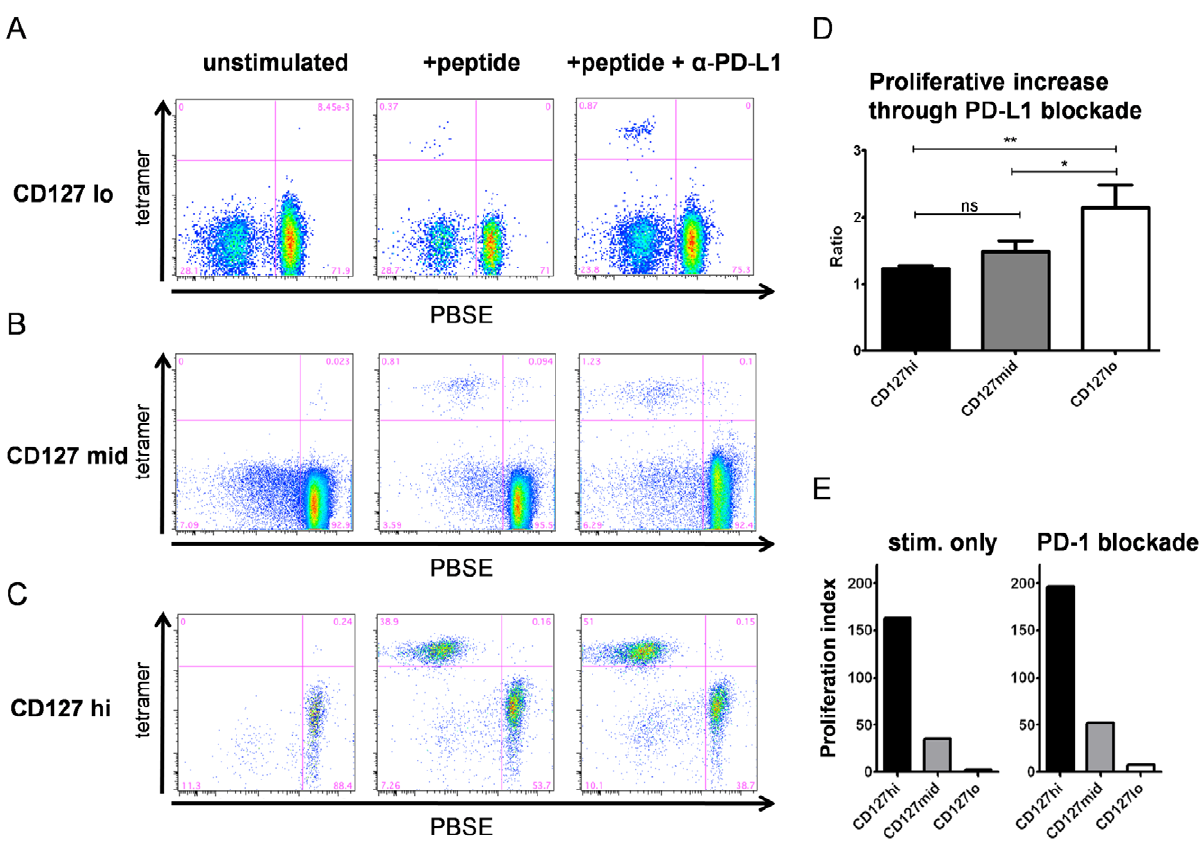
Figure 4. Proliferative capacity and exhaustion inversely correlate with CD127 expression. Proliferation of HCV-specific CD8 + T cells upon peptide stimulation in the presence or absence of PD-L1 blockade was measured by reduction in PBSE fluorescence in short term cultures of 15 patients. Representative stainings are shown for (A) CD127lo (pt.4-NS5-2594), (B) CD127mid (pt. 13-NS3-1073) and (C) CD127hi (pt. 32-NS5-2594) HCV- specific CD8 + T cells. (D) Comparison of the increase in proliferation depending on PD-L1 blockade. Depicted are the mean values and SEM for the ratio (frequency of HCV-specific CD8 + T cells after peptide stimulation and PD-L1 blockade/frequency of HCV-specific CD8 + T cells after peptide stimulation). This ratio reflects the effect of PD-L1 blockade in addition to peptide stimulation. PD-L1 blockade in the cohort analyzed was significantly more effective for peptide-stimulated CD127lo cells (mean 2.2) than for CD127mid (mean 1.5) and CD127hi cells (mean 1.2) (p , 0.01). (E) Proliferation index of peptide-stimulated HCV-specific CD8 + T cells in the presence (right side) and absence (left side) of PD-L1 blockade. The proliferation index (PI) was calculated by the formula (frequency of HCV-specific CD8 + T cells after culture/frequency of HCV-specific CD8 + T cells ex vivo) and reflects the proliferative capacity of the cell, which was highest for CD127hi HCV-specific CD8 + T cells compared to CD127mid and CD127lo cells.